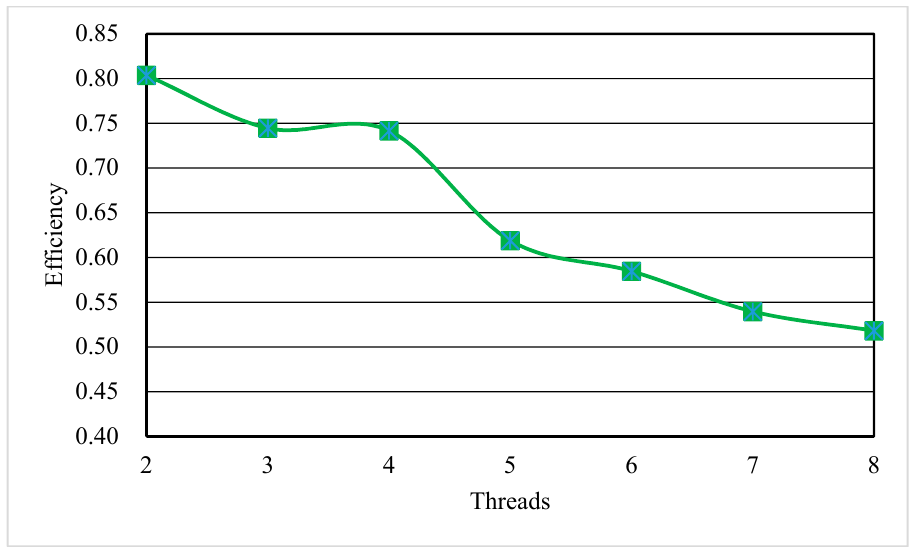
Figure 4. The Speedup and execution time with different number of threads.